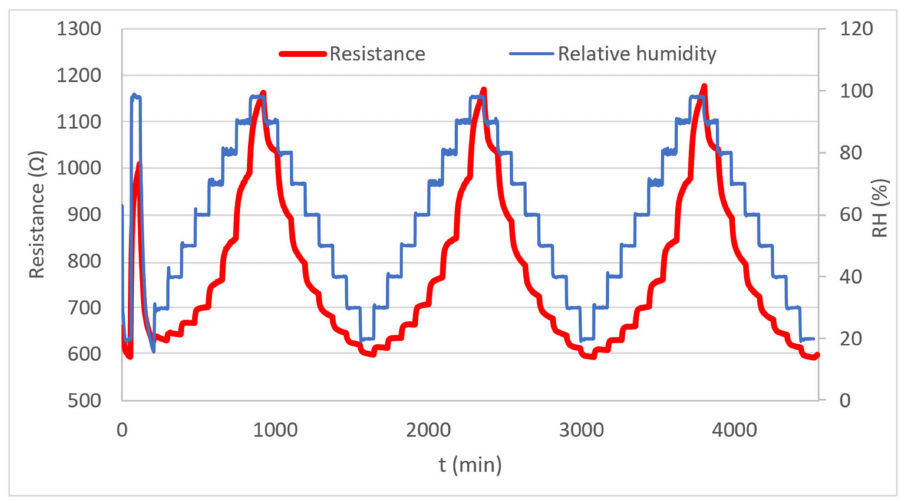
Figure 13. Repeatability of the graphene ‐ based, rectangle ‐ type sensor exposed to three identical hu ‐ midity cycles.